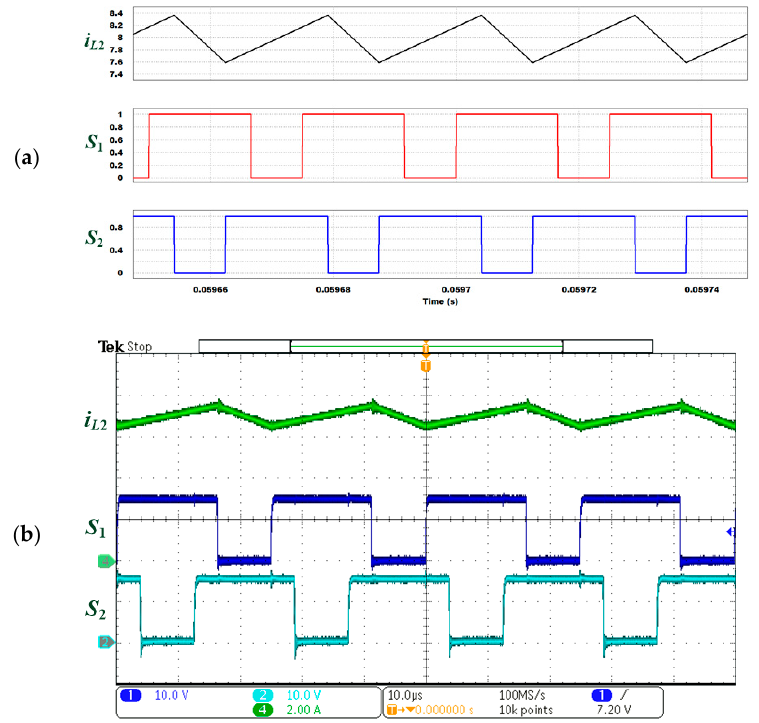
Figure 15. Waveforms of the combined boost converter for gate driving signals V GS 1 and V GS 2 and two-phase inductor current i L 2 . ( a ) Simulated waveforms; ( b ) Experimented waveforms.